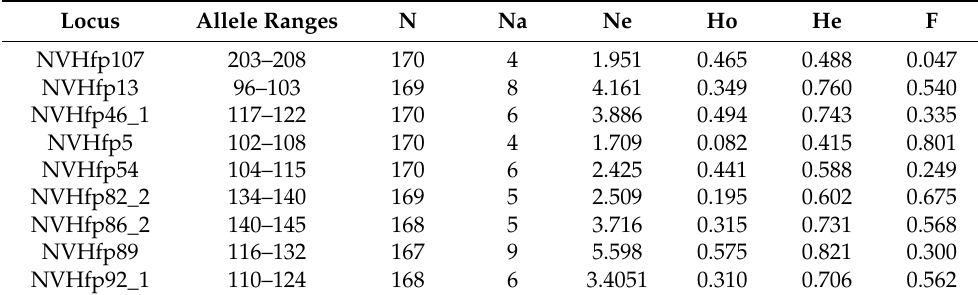
Table 2. Analysis of genetic variability for 6 main providers samples. Locus Allele Ranges